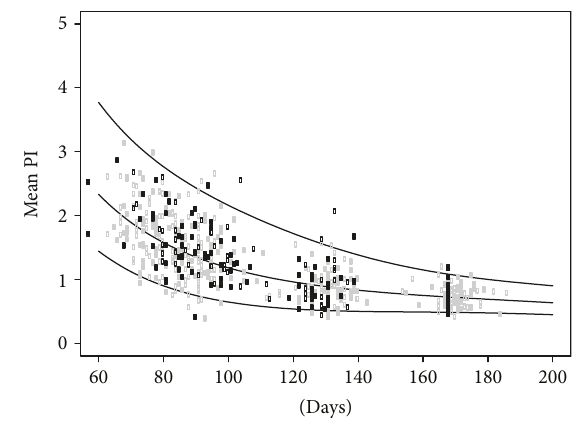
Figure 2: UtAPI percentile curve with 2.5, 50, and 97.5 percentiles. The lines are statistically calculated based on UtAPI measurements of the controls (gray rectangles) and PCOS women (black rectangles). Table 2: Number and time of UtAPI measurements. PCOS women Healthy